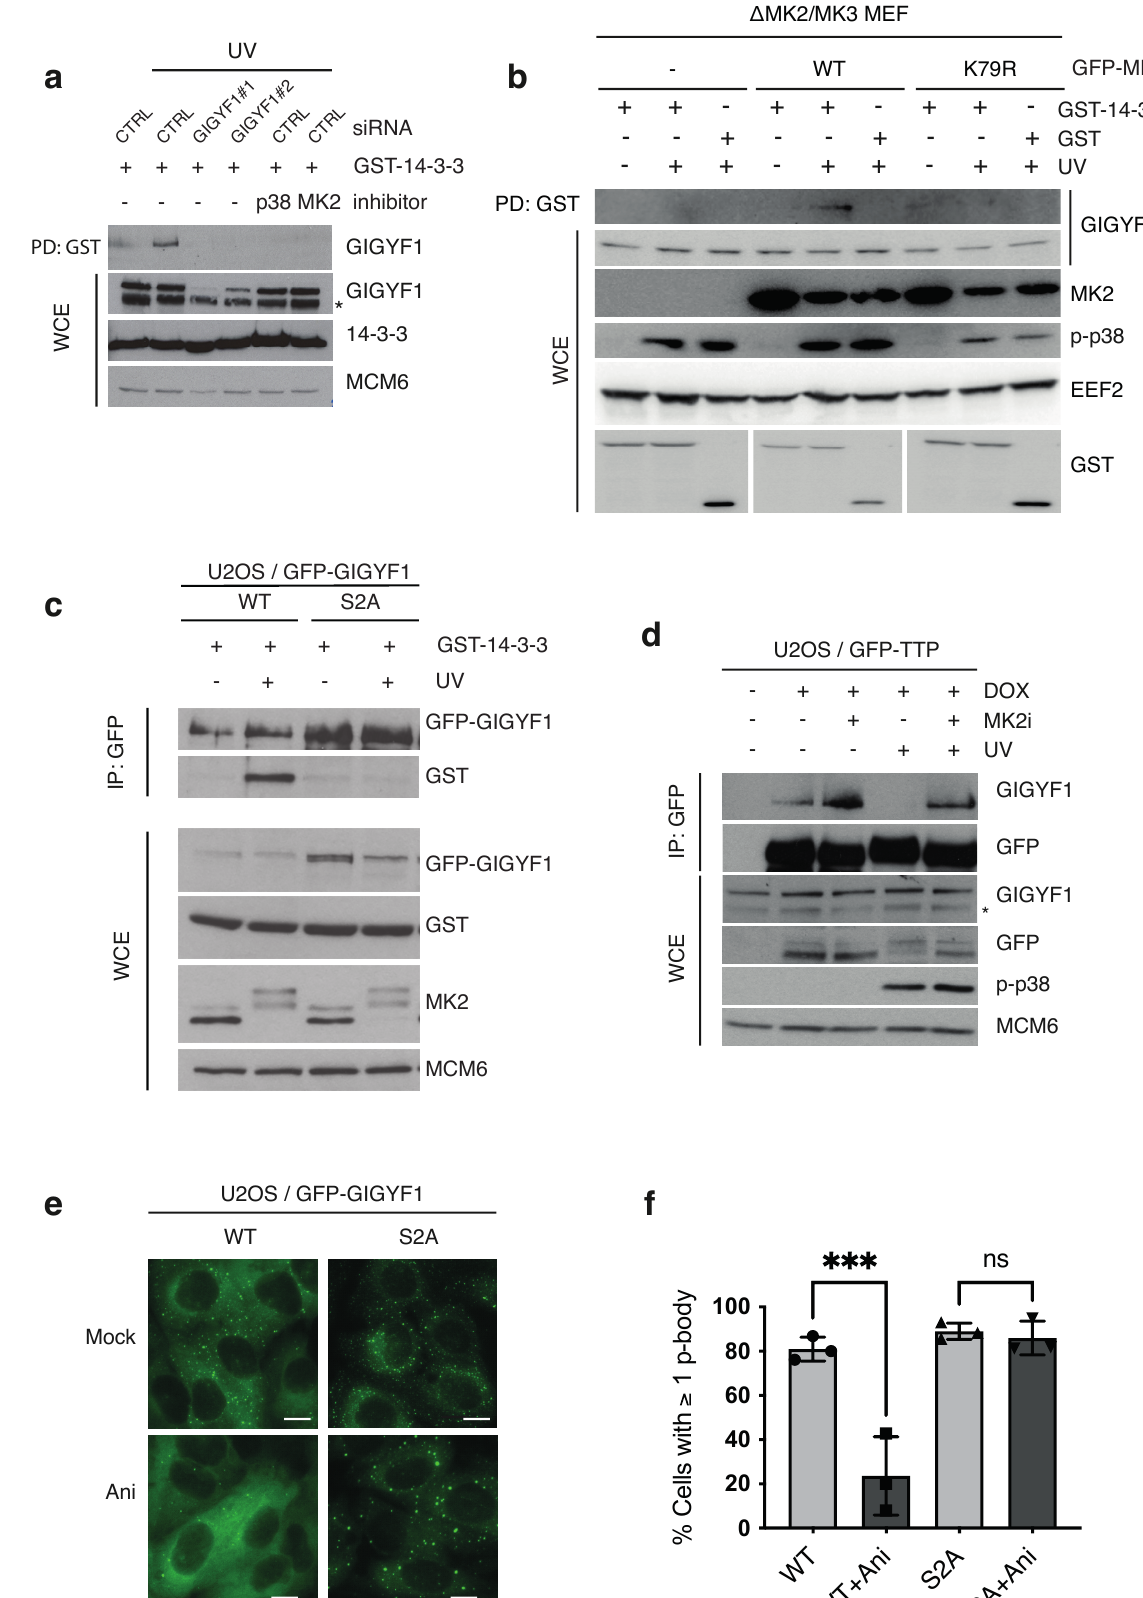
Figure 3. GIGYF1 phospho-mutant retains p -body localization upon cellular stress. ( a ). U2OS cells were transfected with the indicated siRNA, pre-treated with p38 and MK2 inhibitors (0.5 h) and UV-irradiated (50 J/m 2 , 1 h recovery) as indicated. Lysates were incubated with recombinant GST-14–3–3 protein or GST alone. GST pull-down material (PD: GST) and